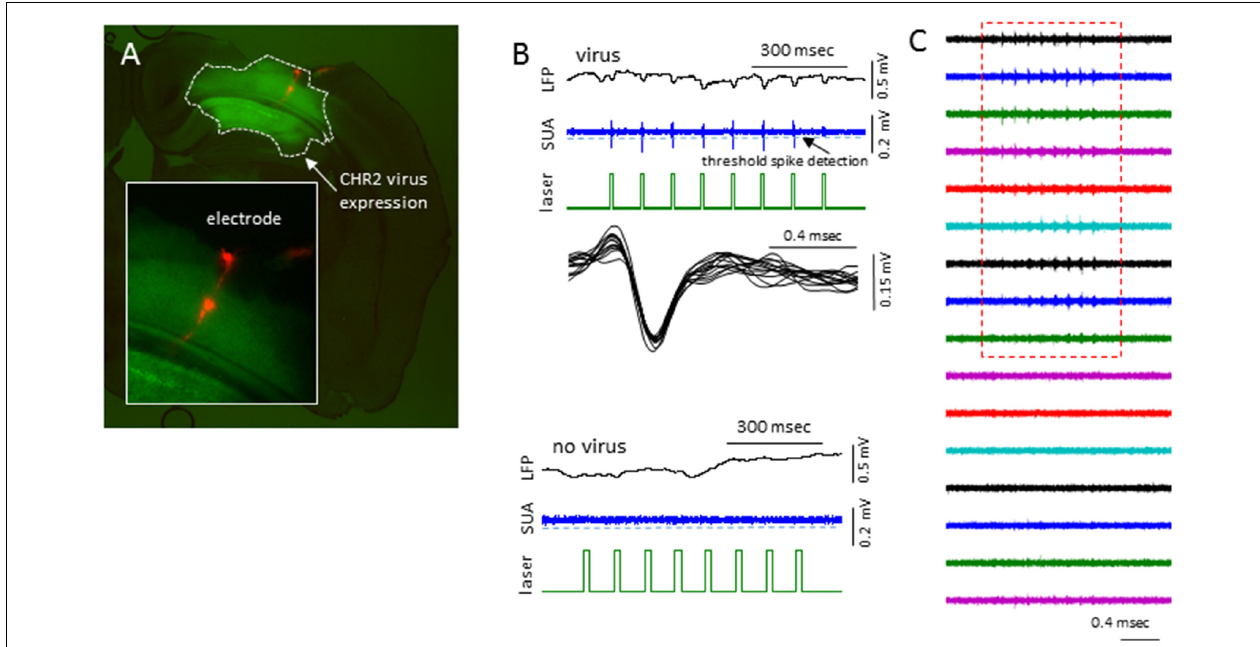
FIGURE 10 | Laser activation induces reliable SUAs in the sham-treated animals. (A) Photomicrograph of brain slice showing the channel-rhodopsin 2 (ChR2) transfected S1 region and location of linear electrodes across the center of the ChR2 transfected area. (B) In AAV-ChR2 transfected sham-treated animals, repeated exposure to short blue laser pulses (0.2 s), reliably and repeatedly induced SUAs in the S1 of ChR2 transfected brain but not in the slices without ChR2 expression. (C) The laser evoked SUA were distributed in the top 9/12 cortical